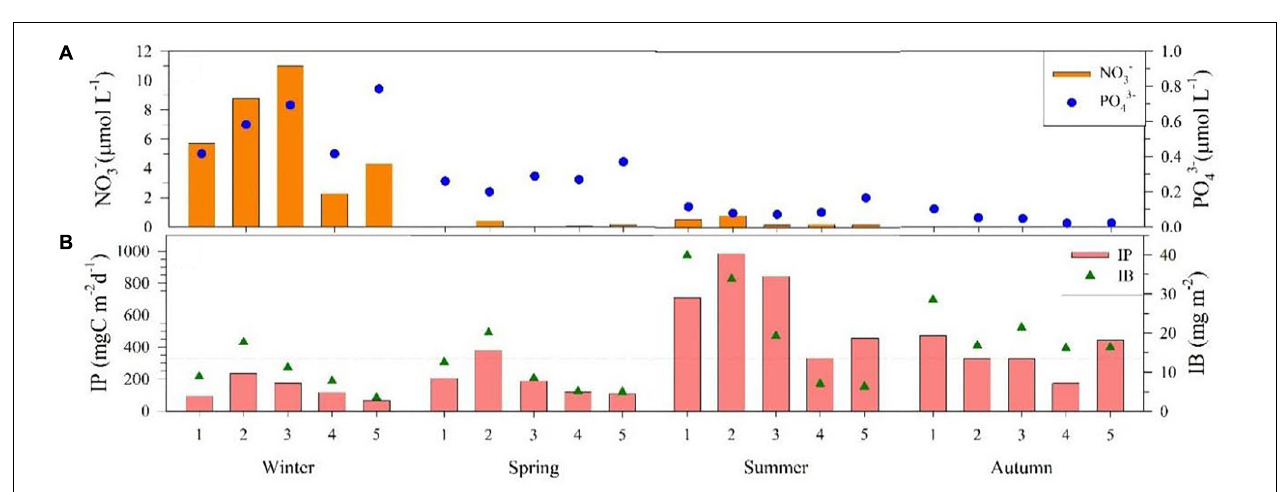
FIGURE 6 | Seasonal trends of (A) average NO 3 − and PO 43 − concentrations (B) euphotic zone integrated Chl a concentration (IB) and primary production (IP) of each sampling station.